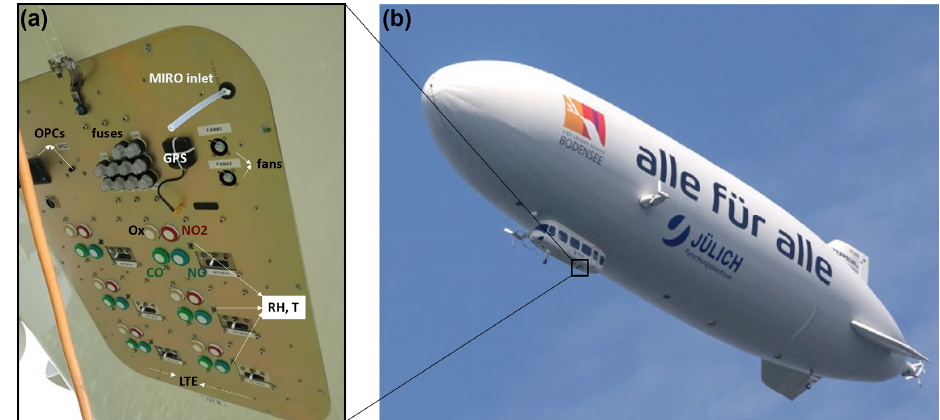
Figure 1. (a) Hatch box, including the sensor setups, located on the bottom of (b) the Zeppelin NT (©Forschungszentrum Jülich/Ralf-Uwe Limbach) that was used as the measurement platform in this work. The reference device, MIRO MGA, was installed inside the gondola but with the inlet line right beside the sensor setups, as shown at the top right of panel (a) . Table 1. Specifications of each sensor setup. Note: ppm is parts per million, and ppb is parts per billion. Parameter Sensor Principle Response time a Accuracy a Range a CO Alphasense CO-B4 Amperometric < 30s ( t 90 ) ± 4ppb 0–1000ppm (precision, 2 σ ) NO Alphasense NO-B4 Amperometric < 45s ( t 90 ) ± 15ppb 0–20ppm (precision, 2 σ ) Alphasense NO2-B43F Amperometric Alphasense Ox-B431 Amperometric (precision, 2 σ ) Aerosol (size distribution, Alphasense OPC-N3 Light scattering 1–30s 0.35–40µm PM 1 , PM 2 . 5 , PM 10 ) b (sampling interval) Temperature Telaire ChipCap